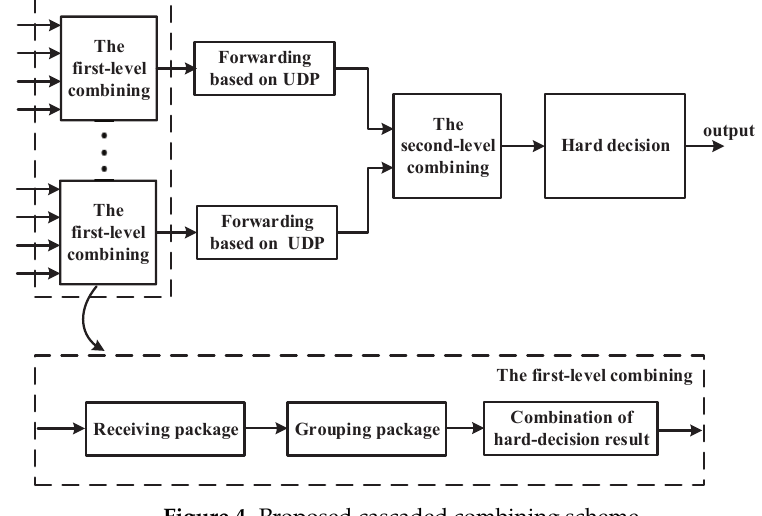
Figure 4. Proposed cascaded combining